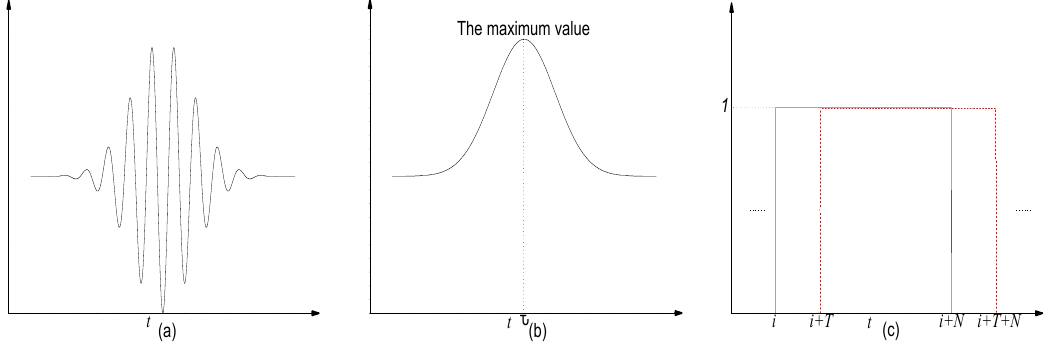
Figure 3. ( a ) Ultrasonic signal; ( b ) Envelope; and ( c ) Rectangular